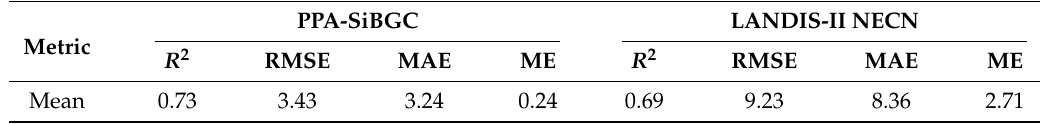
Table 6. Overall mean values across each of the sites and metrics